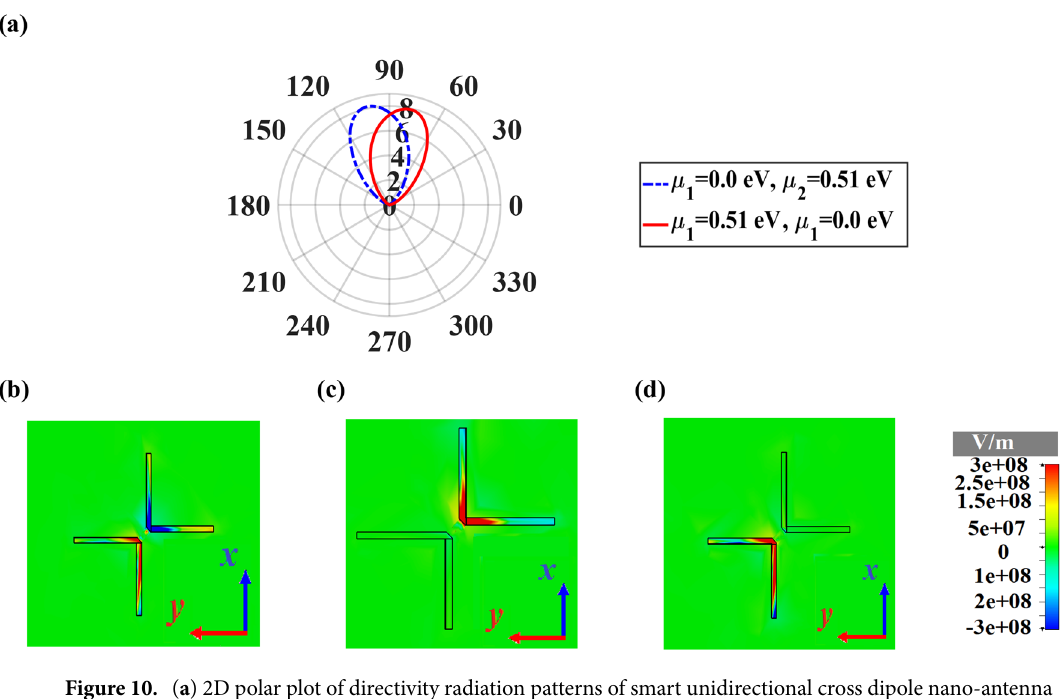
Figure 10. ( a ) 2D polar plot of directivity radiation patterns of smart unidirectional cross dipole nano-antenna at 1550 nm for different states of chemical potential. The distributions of the z-component of electric field at